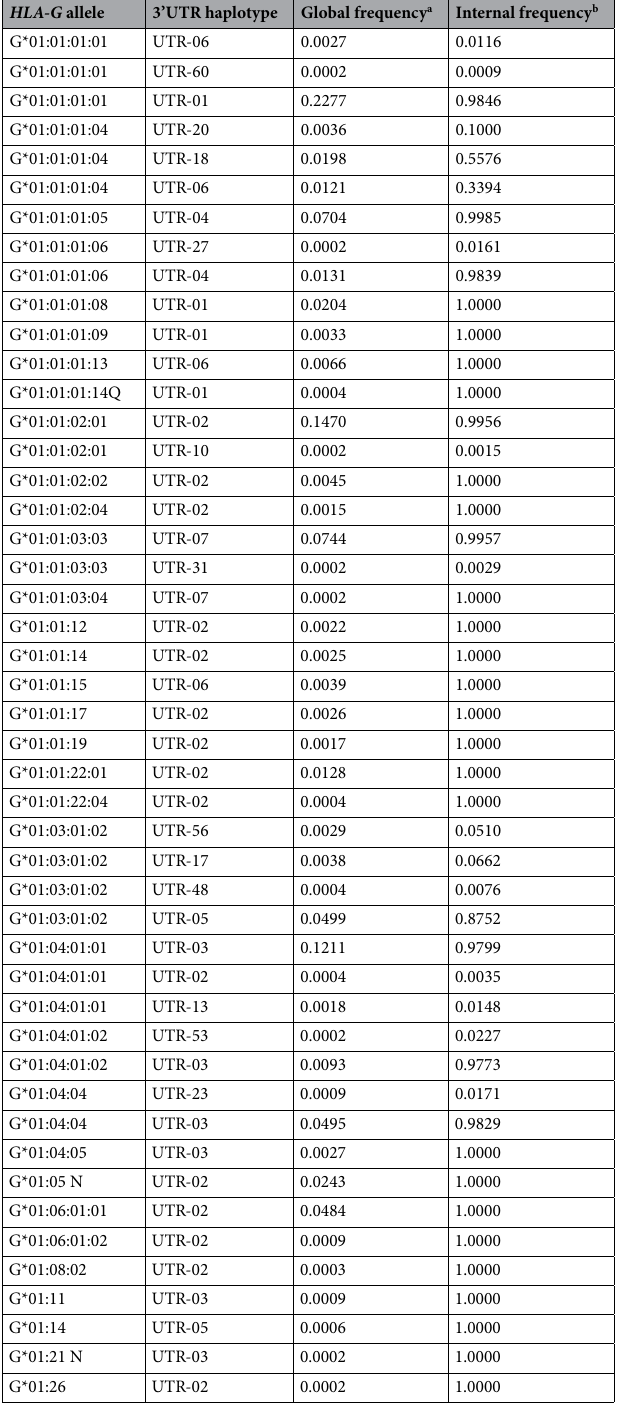
Table 4. The relationship between HLA-G alleles and 3’UTR haplotypes, for combinations that have occurred at least twice in 4640 individuals across the globe. a The global frequency of this haplotype. b Considering all the 3’UTR haplotypes associated with a given genomic allele, this is the frequency in which this specific 3’UTR haplotype follows the given genomic allele. An internal frequency of 1.000 indicates that the given genomic allele always presents the same 3’UTR